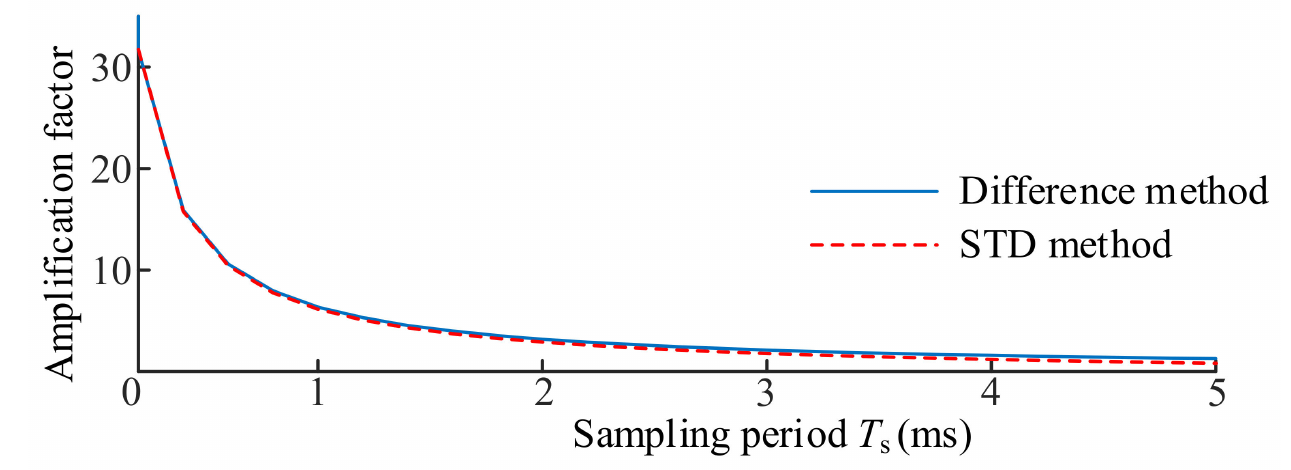
Figure 4. The relationship between Noise amplification factor and T s with different algorithms. The parameters which related with the VQVS are ASTD, ∆ T , n and T s , and the relationship between them are shown in Figure 5. In the figure, the same color lines represented the same delay coefficients, the curves represent the relationship between ASTD and T s , and the straight lines represent the relationship between ∆ T and T s for different delay coefficients. As shown in Figure 5, ASTD decreases and ∆ T increases when n and T s increases. However, in order to improve detection speed and reduce noise, the values of the n and T s can’t be too